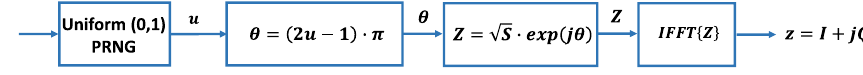
Fig. 18 The COSPAR generator